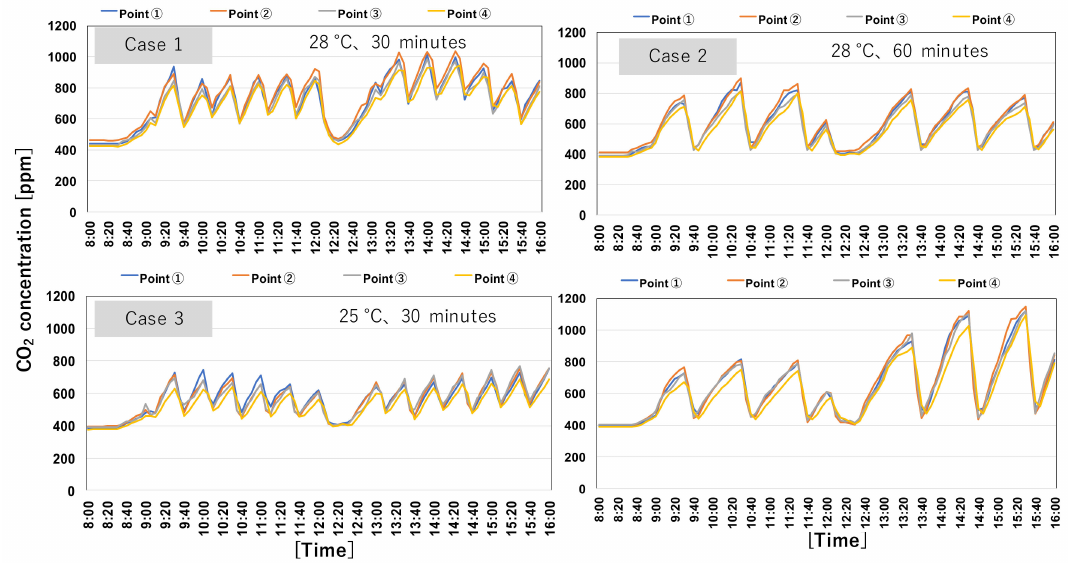
Figure 5. Changes of indoor CO 2 concentration in